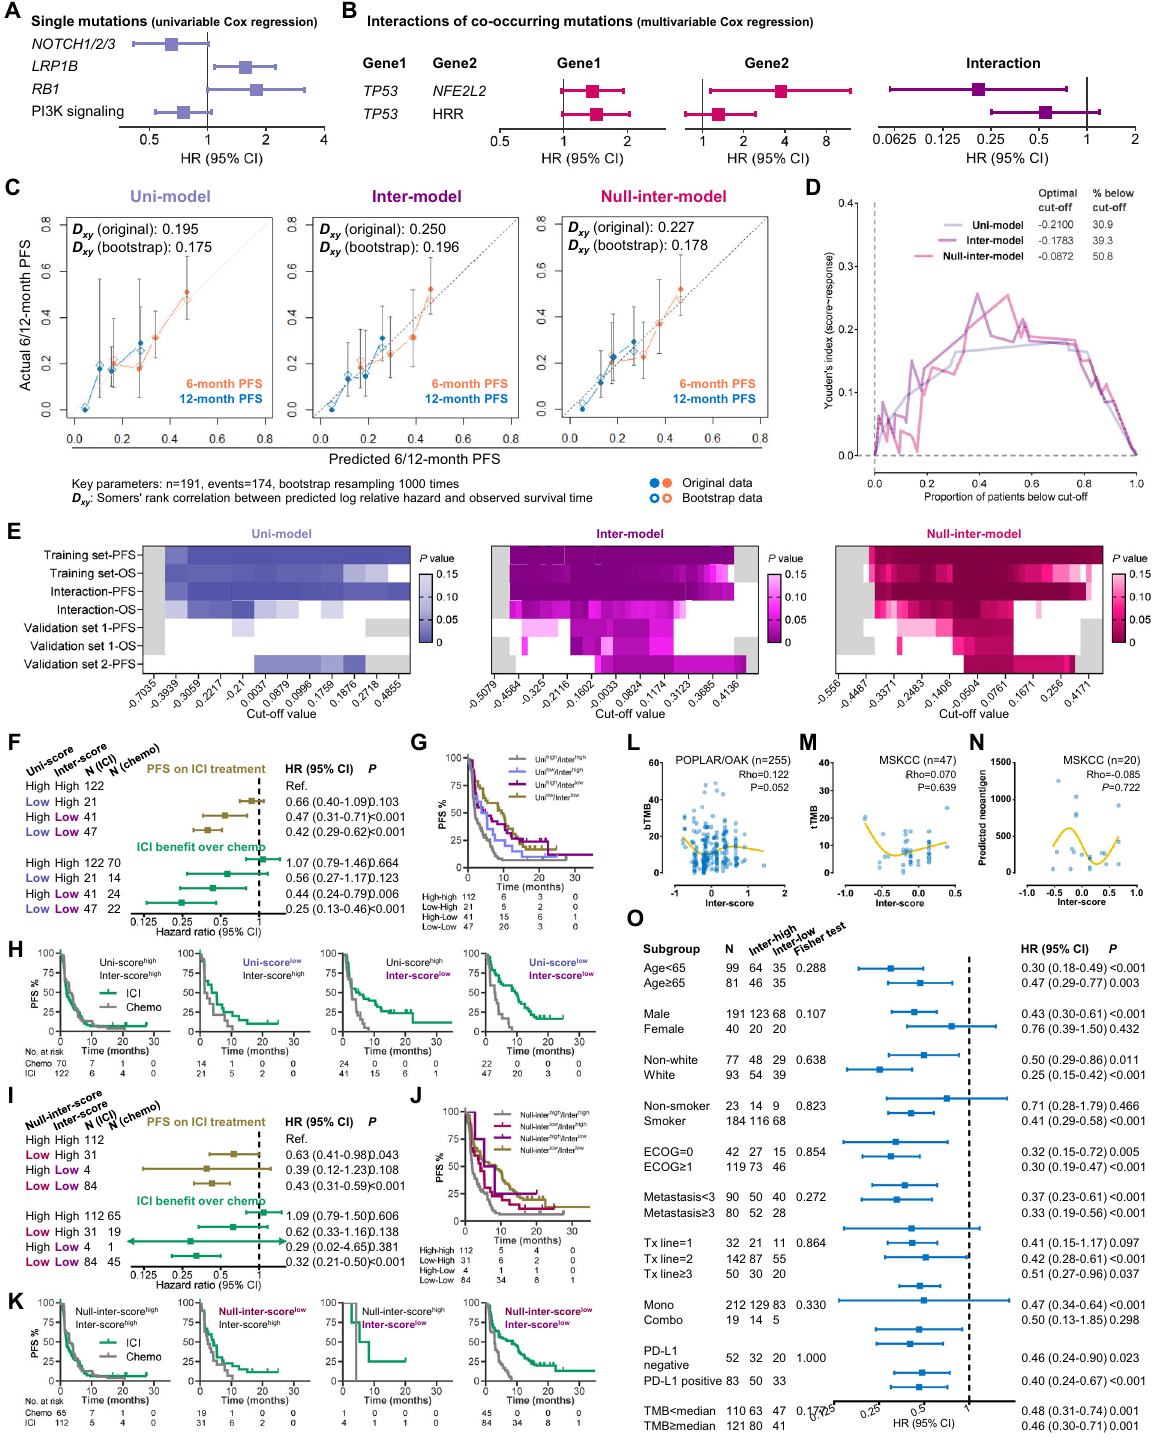
Fig. 5 Outperformance of the inter-model in squamous NSCLC. A , B The single mutations ( A ) and interaction effects of co-mutations ( B ) selected for model development. C Calibration curves of the three-models in the training sets-1/2. D Youden ’ s index based on the receiver operating characteristic curve of the three inter-scores and response to anti-PD-(L)1 monotherapy in the training sets-1/2. E Summary of the performances of the three models in all training/validation sets. F – H Comparison between the uni-model and the inter-model when two results are inconsistent ( F ). KM curves illustrating PFS on ICI treatment ( G ) and PFS bene fi t from ICI therapy over docetaxel ( H ). I – K Comparison between the null-inter-model and the inter-model when two results are inconsistent ( I ). KM curves illustrating PFS on ICI treatment ( J ) and PFS bene fi t from ICI therapy over docetaxel ( K ). L – N Association of the inter-score with blood TMB ( L ), tissue TMB ( M ), and neoantigen load ( N ). O Effectiveness of the inter-score in patients with different clinicopathological features, TMB, and PD-L1. Abbreviations: ICI immune checkpoint inhibitor, KM Kaplan-Meier, NSCLC nonsmall cell lung cancer, OS overall survival, PD-1 programmed death-1, PD-L1 programmed death-ligand 1, PFS progression-free survival, TMB tumor mutational